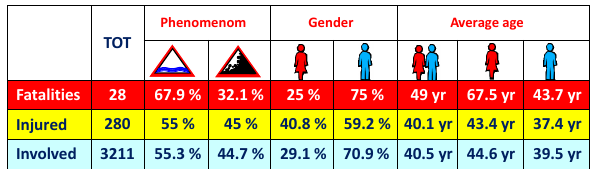
Figure 2. Schematization of phenomenon, gender and age relation- ships among fatalities, injures and people involved in DHE in Cal- abria during the study